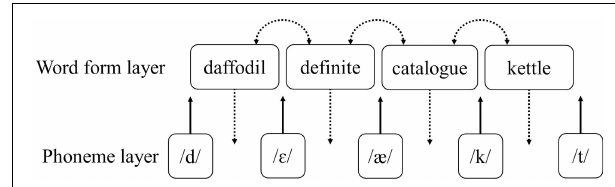
FIGURE 1 | Visualization of lexical configuration versus lexical engagement properties in the context of spoken word recognition. Note that representations are depicted as localist nodes for ease of visualization, but no theoretical commitment is made regarding their